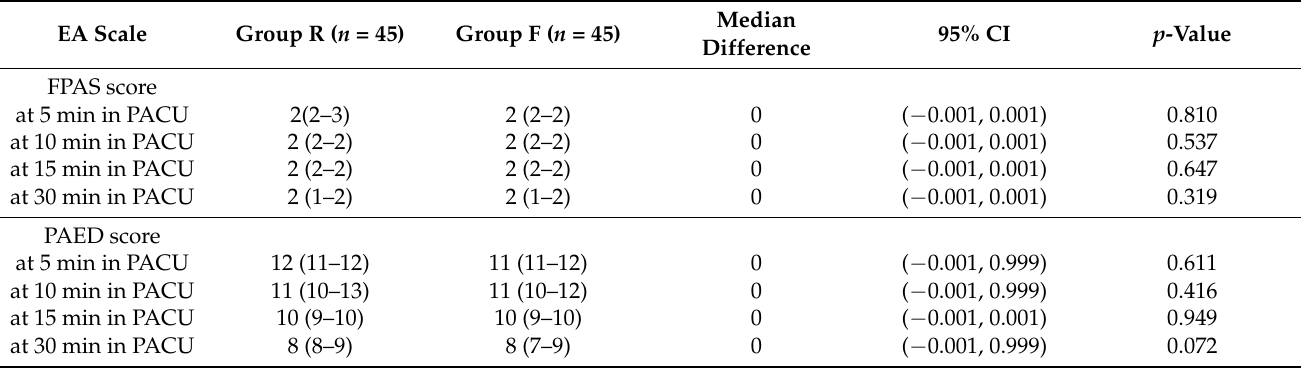
Table 2. Scores of emergence agitation at four time points in the post-anesthetic care unit.